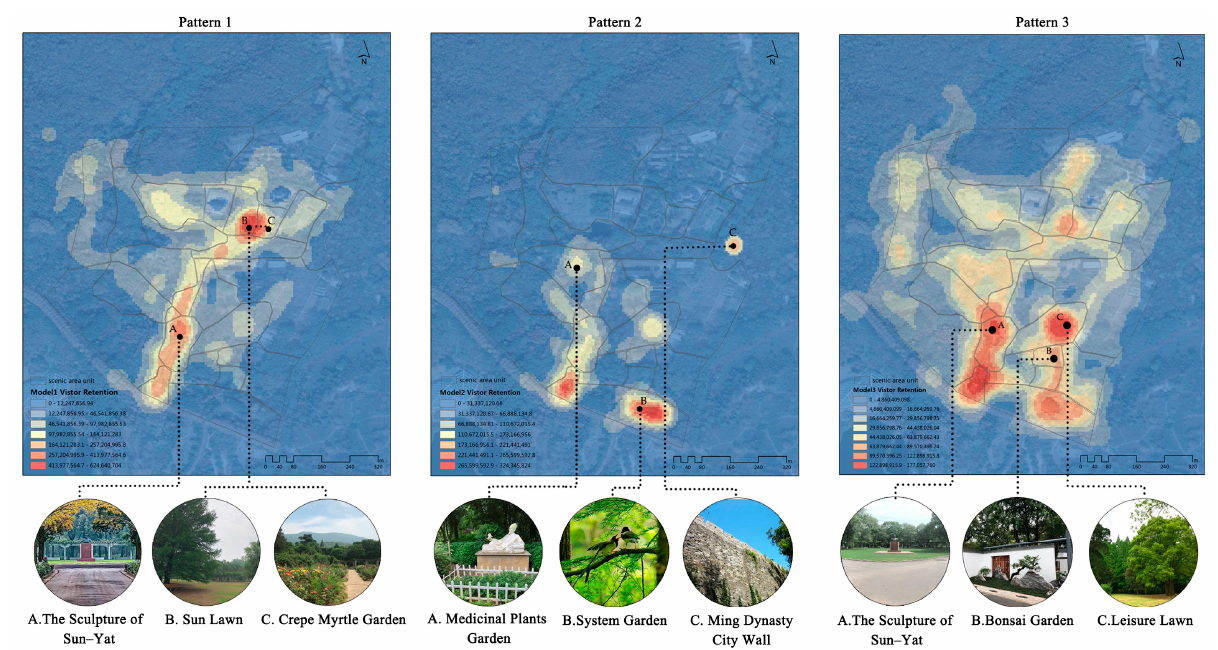
Figure 6. Three behavioral patterns of spatial